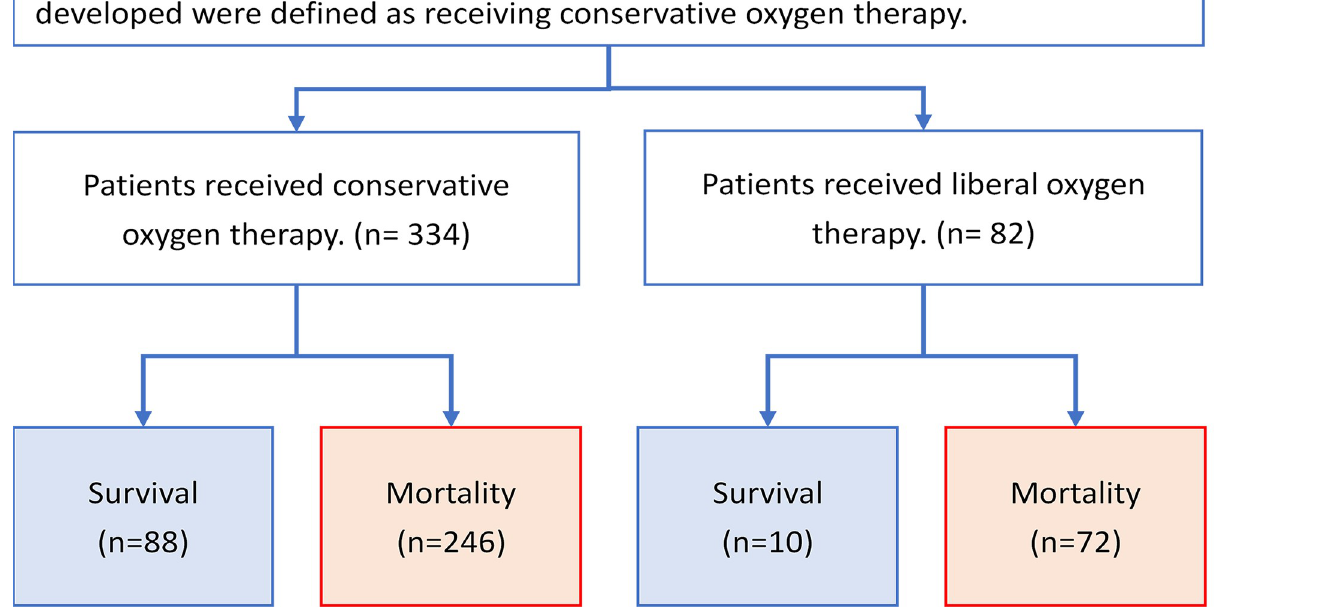
Fig 1. Flowchart of enrollment and the status of patients upon enrollment.